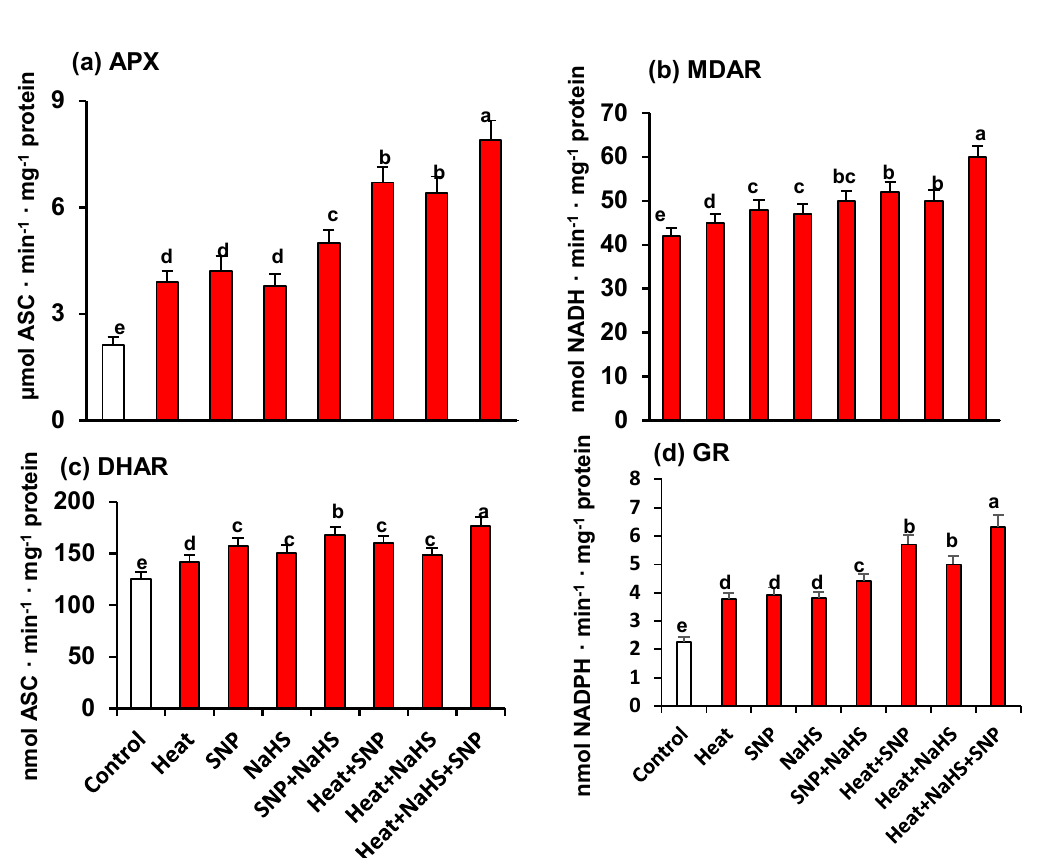
Figure 7. Activity of the ascorbate-glutathione cycle enzymes in wheat ( Triticum aestivum L. var. WH 542) leaves treated with SNP (100 µ M) and/or NaHS (200 µ M) in the presence (40 ◦ C) or absence (25 ◦ C) of heat stress at 30 days after sowing (DAS). ( a ) Ascorbate peroxidase (APX) activity. ( b ) Monodehydroascorbate reductase (MDAR) activity. ( c ) Dehydroascorbate reductase (DHAR) activity. ( d ) Glutathione reductase (GR) activity. Data are presented as treatments mean ± SE ( n = 4). Data followed by the same letter are not significantly different by LSD test at ( p < 0.05). Asc, ascorbate; SNP, sodium nitroprusside; NaHS, sodium